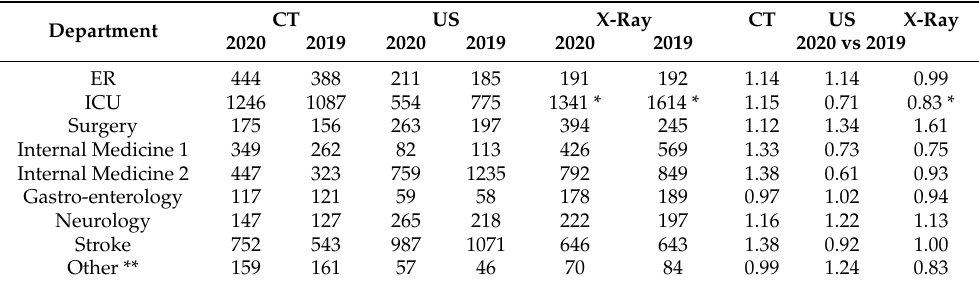
Table 3. The number of examinations per 1000 patients performed in 2019 and 2020 in individ- ual hospital departments. The detailed list includes departments ordering the largest number of examinations. Other departments, as well as hospital and external clinics, are presented